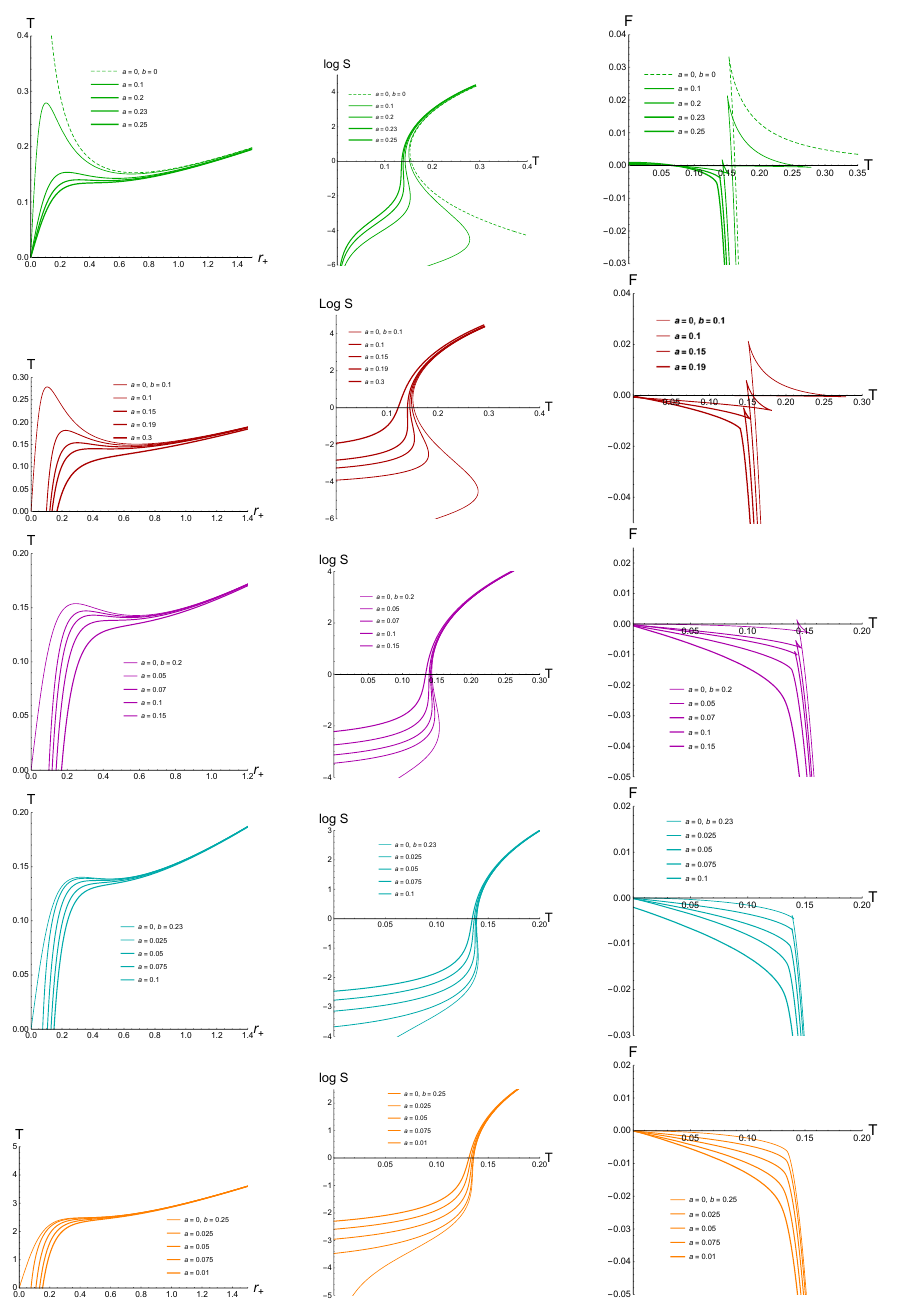
Figure 5 . The plots in the first column show the dependence of temperature on r h for varieties a and b . The plots in the second column show a logarithmic dependence of entropy on temperature. The plots in the third column show the dependence of free energy on